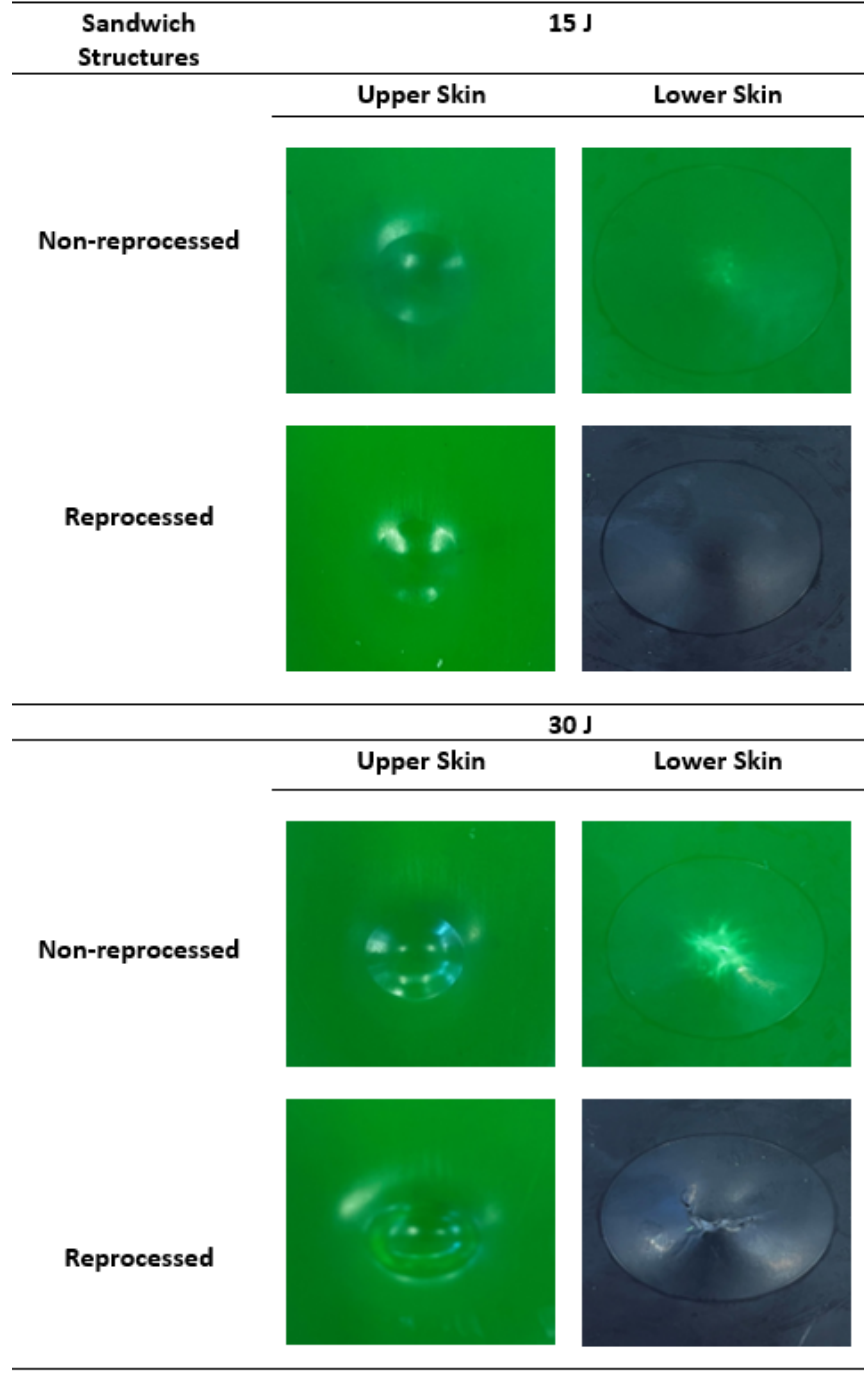
Figure 4. Impact damage at lower and upper skins of non-reprocessed and reprocessed sandwich structures at 15 J and 30 J impact energy levels.